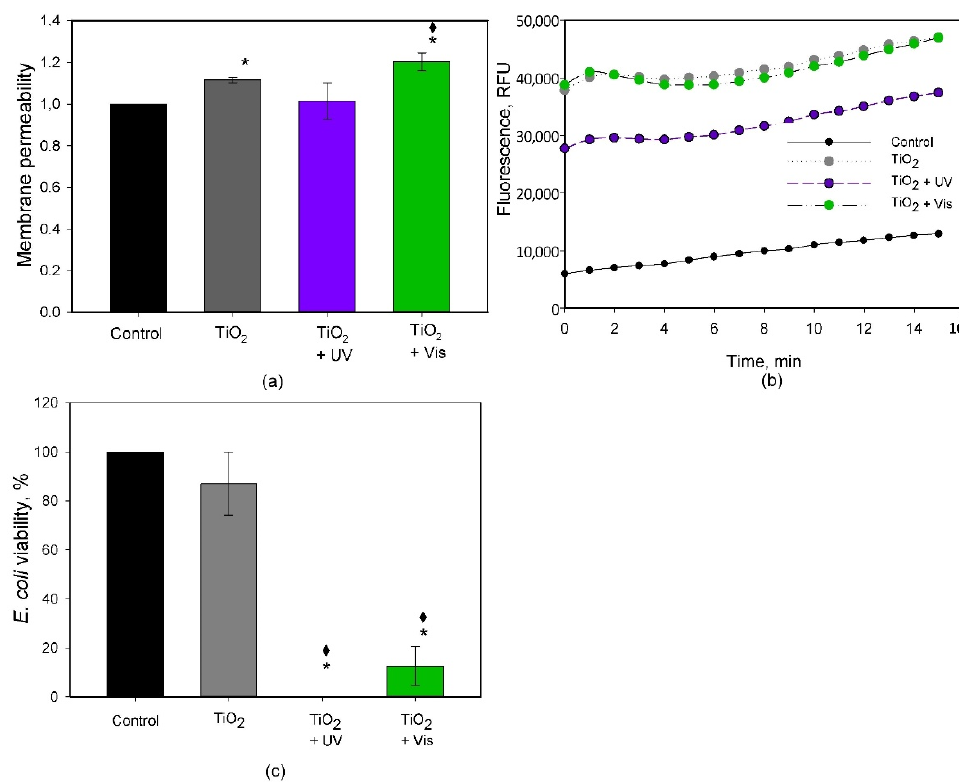
Figure 7. Effects of light and TiO 2 on E. coli cells: ( a ) outer membrane permeability; ( b ) intracellular ROS concentration and ( c ) viability of E. coli . The experiments were performed in PBS buffer containing 0.1% glucose, pH 7.4. Concentrations of the cells and TiO 2 were 3 × 10 7 cfu/mL and 0.3 mg/m, respectively. * and ♦ mark experimental values which are significantly different from the control sample and other samples respectively (more details on statistical analysis are provided in Section 4.5).